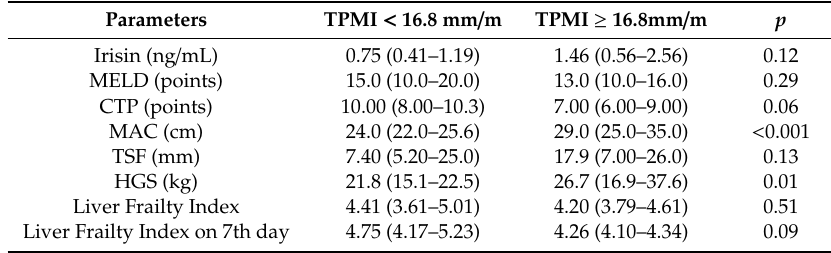
Table 7. Comparison of analyzed parameters between cirrhotic patients with and without sarcopenia according to TPMI